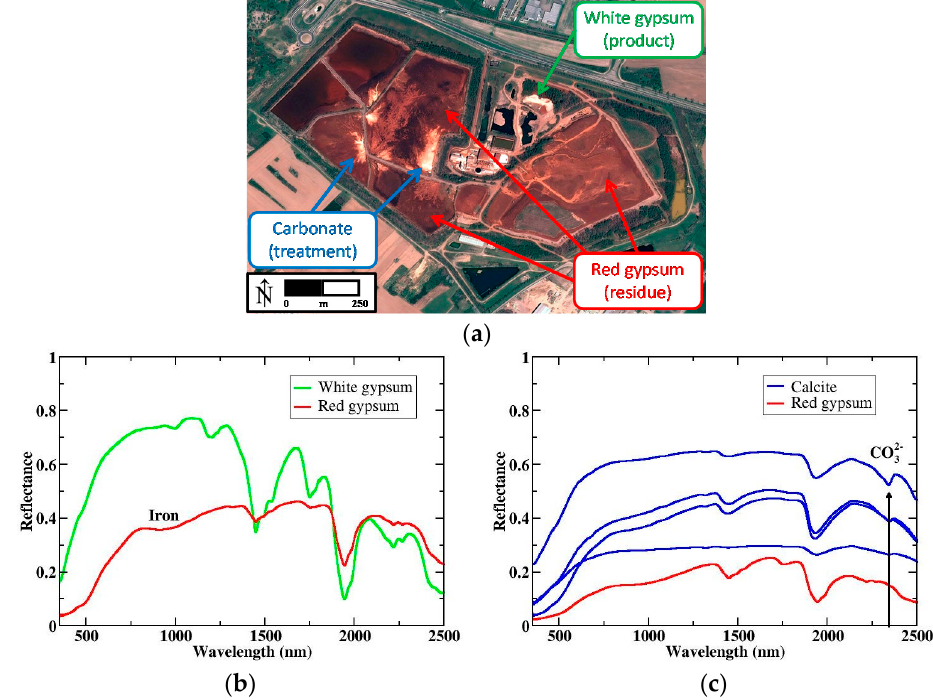
Figure 3. ( a ) Ochsenfeld waste storage area (Séché); and laboratory spectra of main materials: ( b ) red and white gypsum; ( c ) samples presenting a mixture of calcite and iron oxihydroxides in various proportions compared to red gypsum. The Ochsenfeld extension is about 0.5 × 1.0 km 2 .